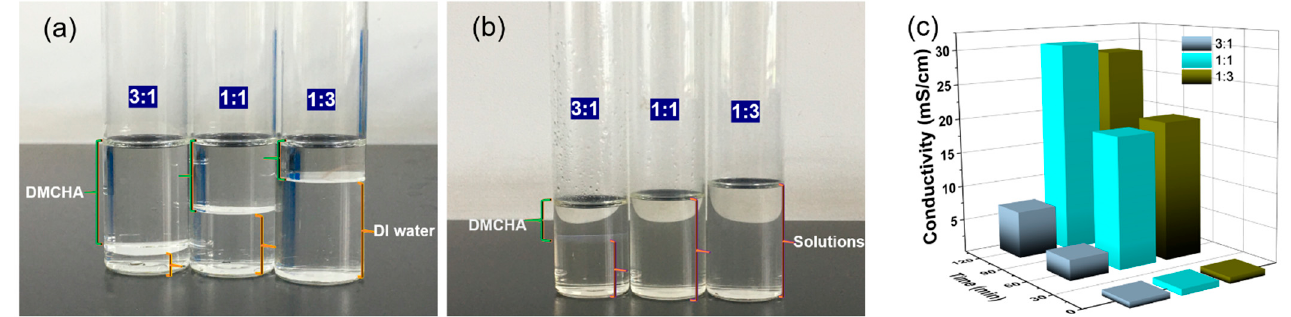
Figure 4. Digital photos of DMCHA and DI water mixtures with different volume ratios before ( a ) and after ( b ) bubbling CO 2 for 120 min, and conductivity of the mixtures at different times ( c ).